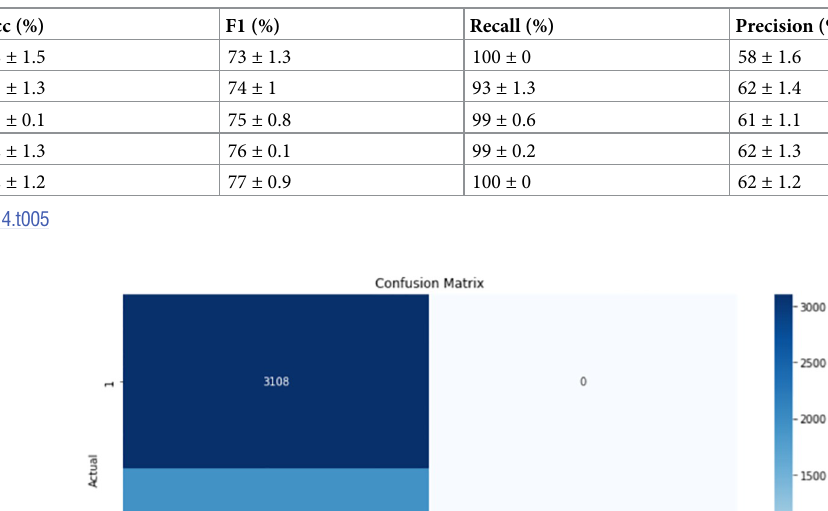
Table 5. This table shows the results of the machine learning models using data from the BRCA 2 gene.